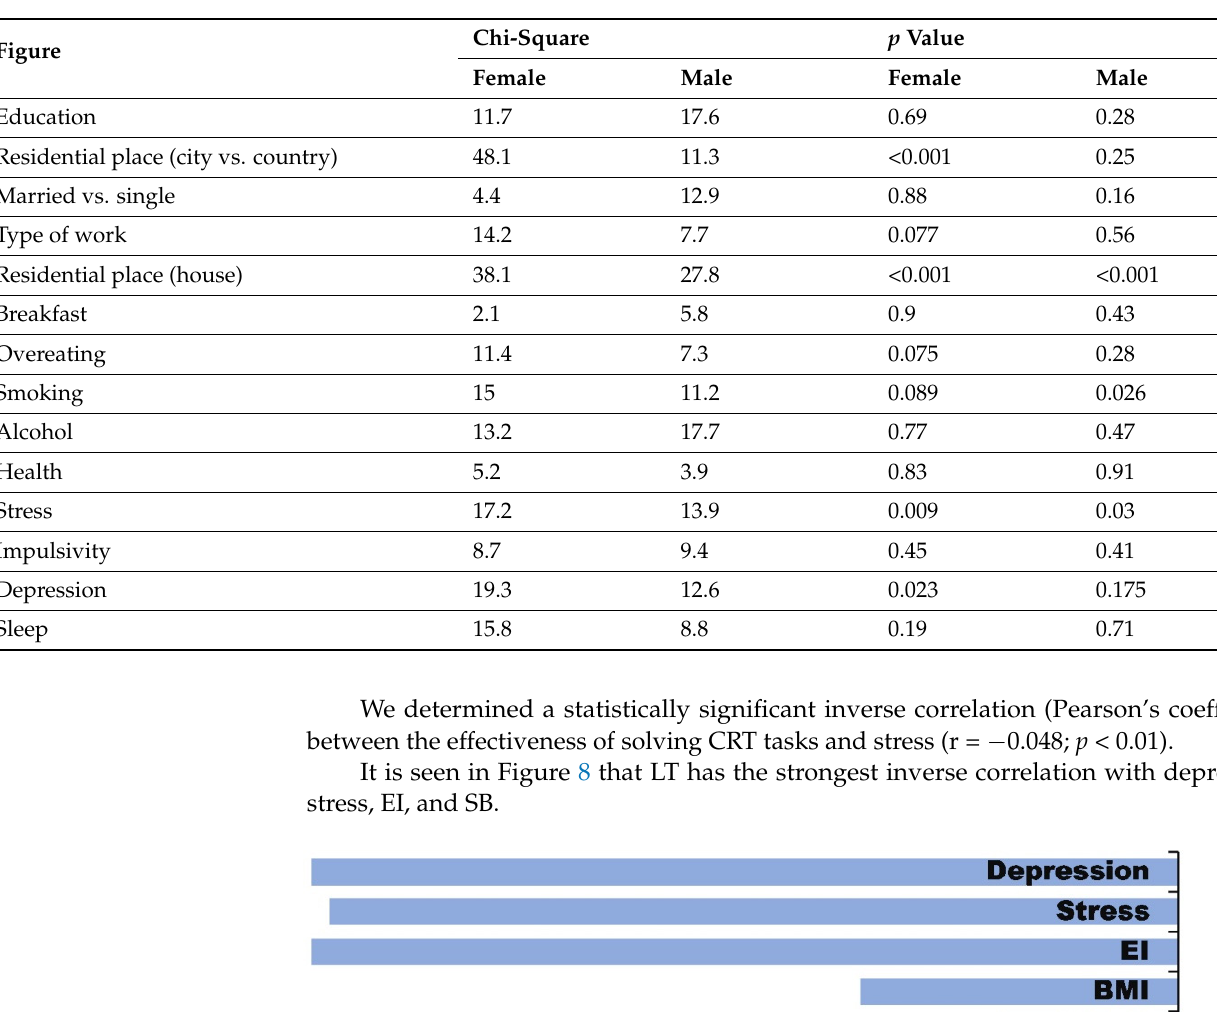
Table 1. Relationships between the effectiveness of solving CRT tasks and sociodemographic and healthy lifestyle factors.